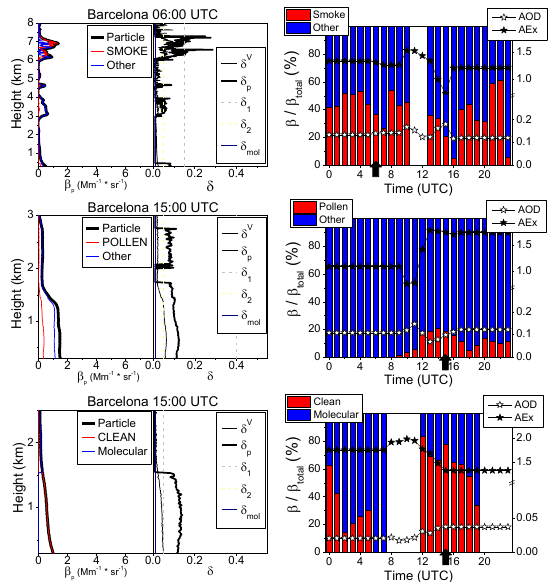
Figure 2. The same as Fig. 1, but for all other cases (from top to bottom panels): fires smoke, pollen and clean